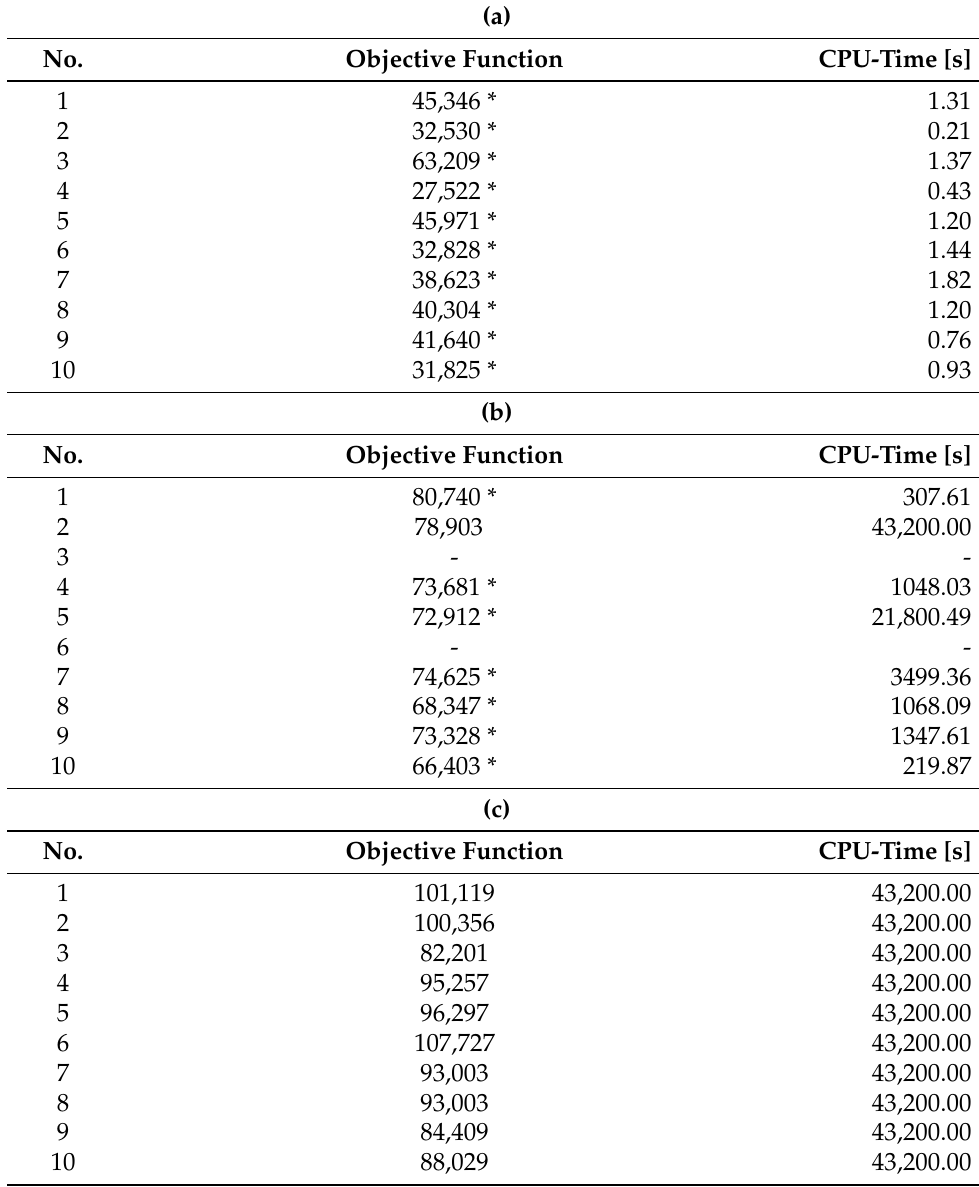
Table 3. Optimal or near-optimal solution obtained by the Gurobi optimizer. Symbol “-” means that no feasible solutions can be found by the Gurobi optimizer 9.1.1 within 12 h. Symbol “*” means that an optimal solution can be obtained using the Gurobi optimizer 9.1.1 within 12 h. ( a ) n = 10. ( b ) n = 30. ( c ) n =